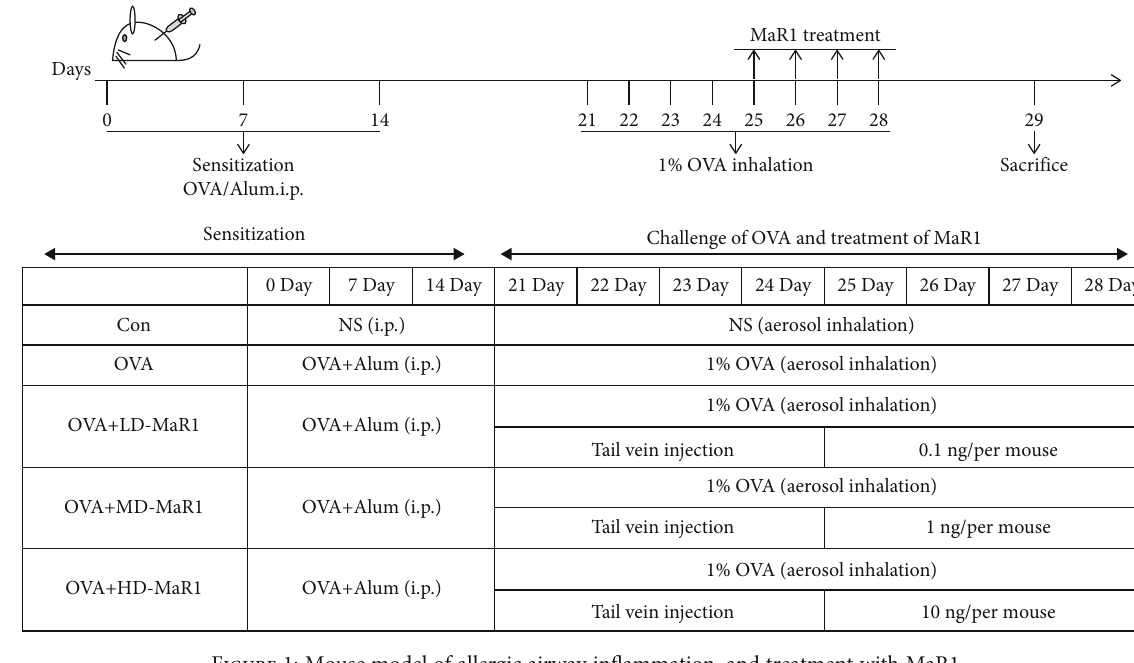
Figure 1: Mouse model of allergic airway in fl ammation, and treatment with